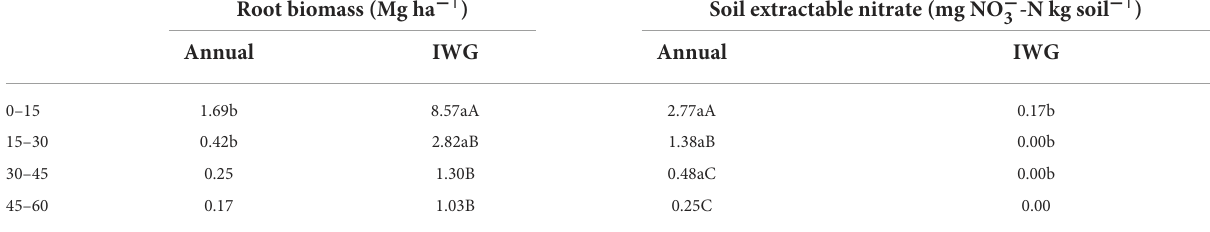
TABLE 3 Mean root biomass and soil extractable nitrate (mg NO − 3 -N kg soil − 1 ) at four depth intervals from 0 to 60cm at the end of the study in